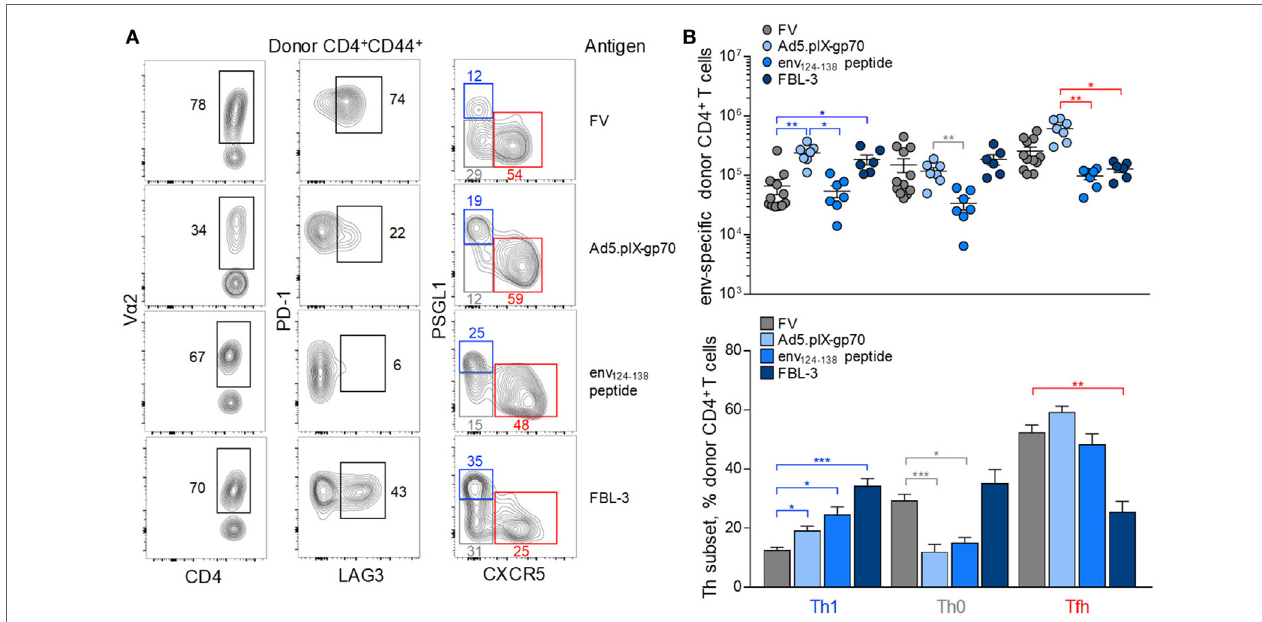
FigUre 5 | Effect of immunization regimen on the follicular helper cells (Tfh) response to F-MLV env. (a) Flow cytometric analysis of V α 2, PD-1, LAG3, PSGL1, and CXCR5 expression in env-reactive CD4 + T cells isolated from the spleens of WT recipients on day 7 post transfer and priming with the indicated immunization regimens [intermediate Friend virus (FV) infection, n = 3; Ad5.pIX-gp70 vaccination, n = 7; env 124-138 peptide in Sigma Adjuvant System immunization, n = 7; FBL-3 challenge, n = 6]. (B) Absolute number ( top ) and mean frequency ( ± SEM) ( bottom ) of T helper (Th) subsets, defined by PSGL1 and CXCR5 expression, in env-reactive donor CD4 + T cells from the same donor cells as in (a) .